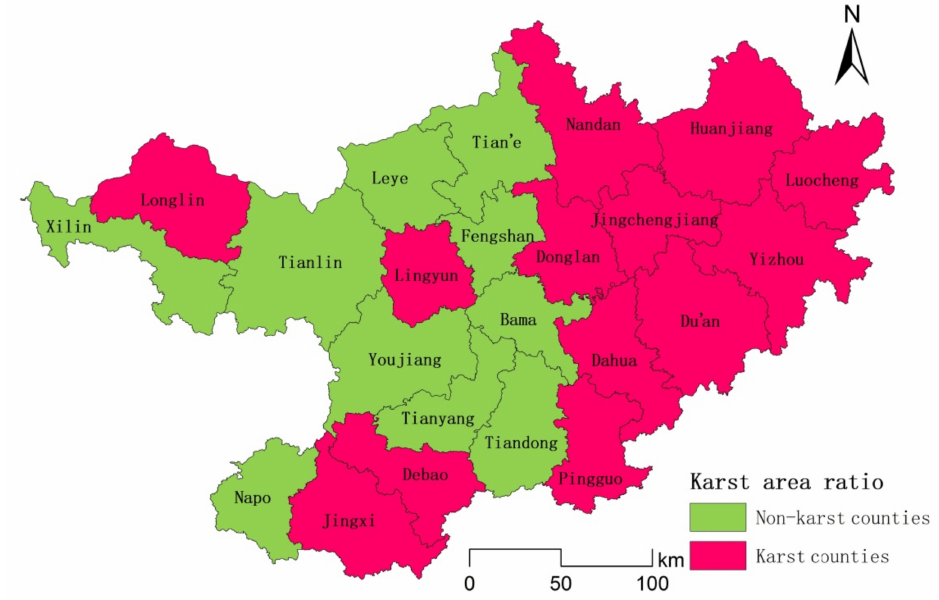
Figure 5. Karst county distribution map of northwestern